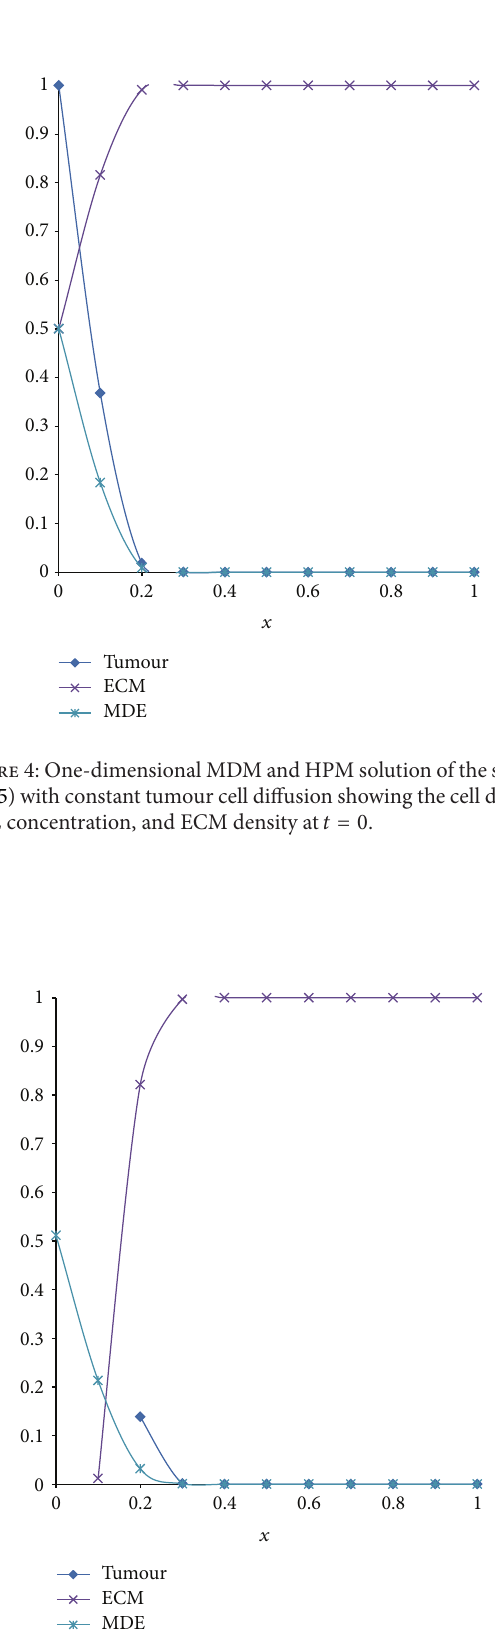
Figure 5: One-dimensional MDM and HPM solution of the system (3)–(5) with constant tumour cell diffusion showing the cell density, MDE concentration, and ECM density at 𝑡 = 1